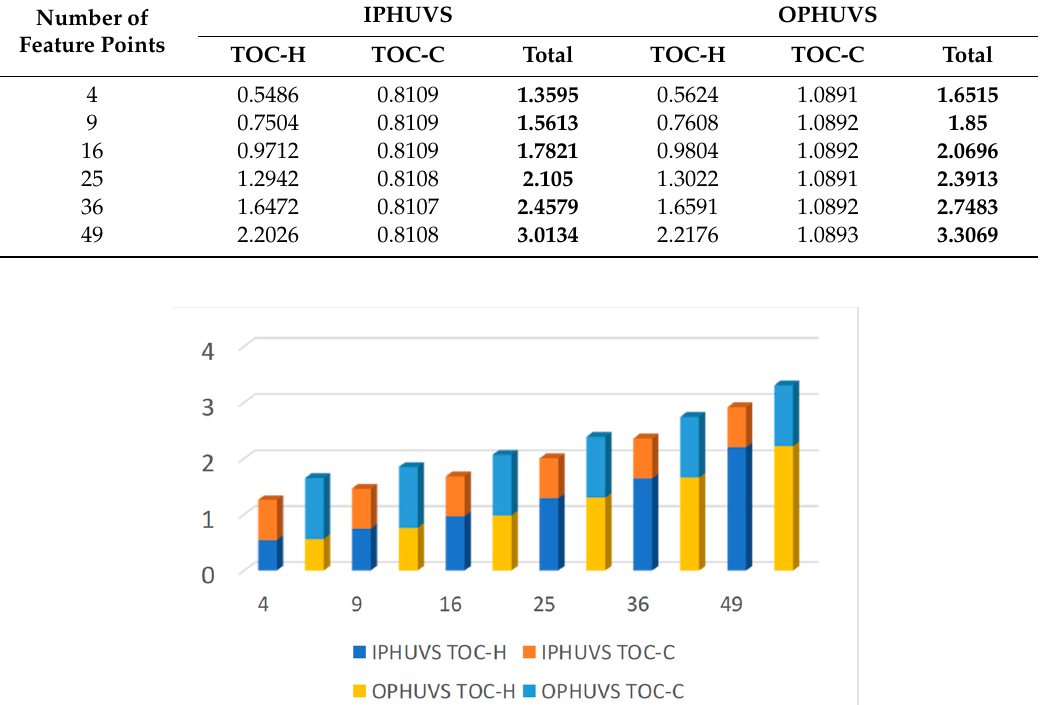
Table 4. Detailed value of the TOC of the original PHUVS and improved PHUVS.